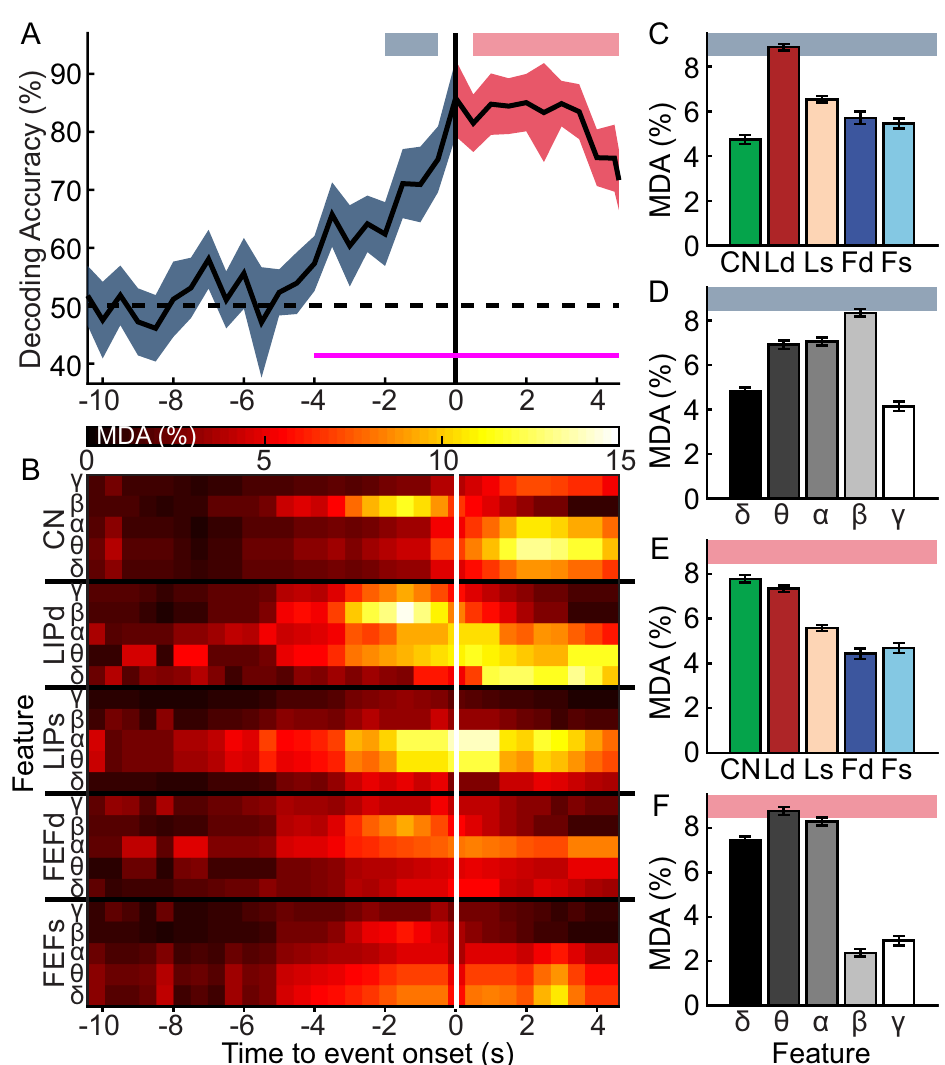
Fig 10. VPC and stare controls are readily decodable on a similar time-frame as changes in consciousness, and represent a clear shift in the relative importance of different frequencies. A , Decoding accuracy ( ± SE) across time relative to event onset of VPC and stare controls using 25 frequency ( δ , θ , α , β , γ ) by brain area (CN, Ld, Ls, Fd, Fs) features. Thin saturated pink line shows period of significance when decoding accuracy is greater than chance (50%). B Mean decrease in accuracy (MDA) attributed to each model feature across time. Higher values indicate higher feature importance. D - F , MDAs further analyzed for the period of time just prior to event onset (thick blue horizontal bar in ( A )) for features by ( C ) area and ( D) frequency, and for the period of time just after VPC onset (thick red horizontal bar in ( A )) for features by ( E ) area and ( F ) frequency. Bar graphs show average MDA ( ± SD). 10E, |t(1998)| � 210.56, n = 2000, p � 2.0x10 -15 ), and features related to δ , θ , and α power c (Fig 10F, |t(1998)| � 552.2, n = 2000, p � 1.6x10 -15 ) conveyed more information than others c (see Fig 10B for the most important individual features, i.e., CN , Ld , Ls , and Fs ). δ , θ , α δ , θ δ θ , α These results indicate that VPC is associated with a substantial increase in low frequency activ- ity between 1–15 Hz. As this activity is most substantial and informative when found in sub- cortical and parietal structures, these regions may play the largest role in inducing and promoting VPC.